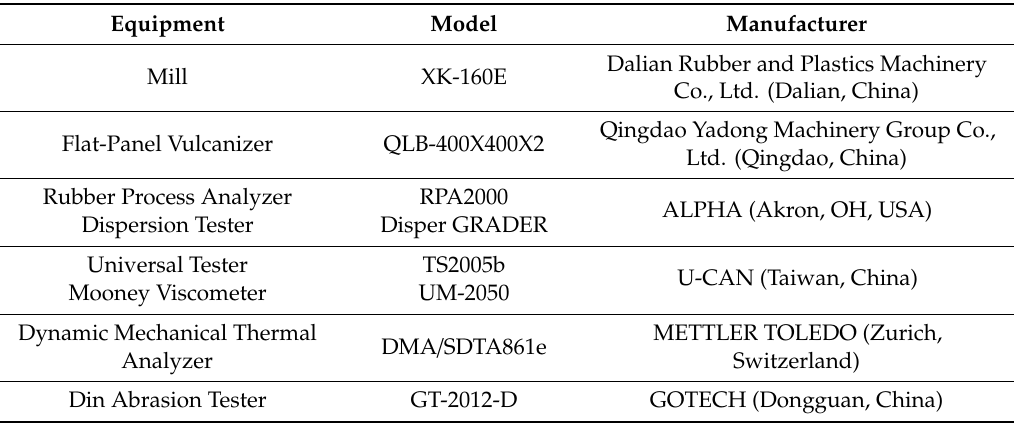
Table 2. Experimental equipment.